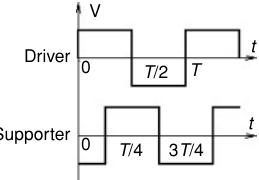
Figure 5 The control signals of the normal strategy.